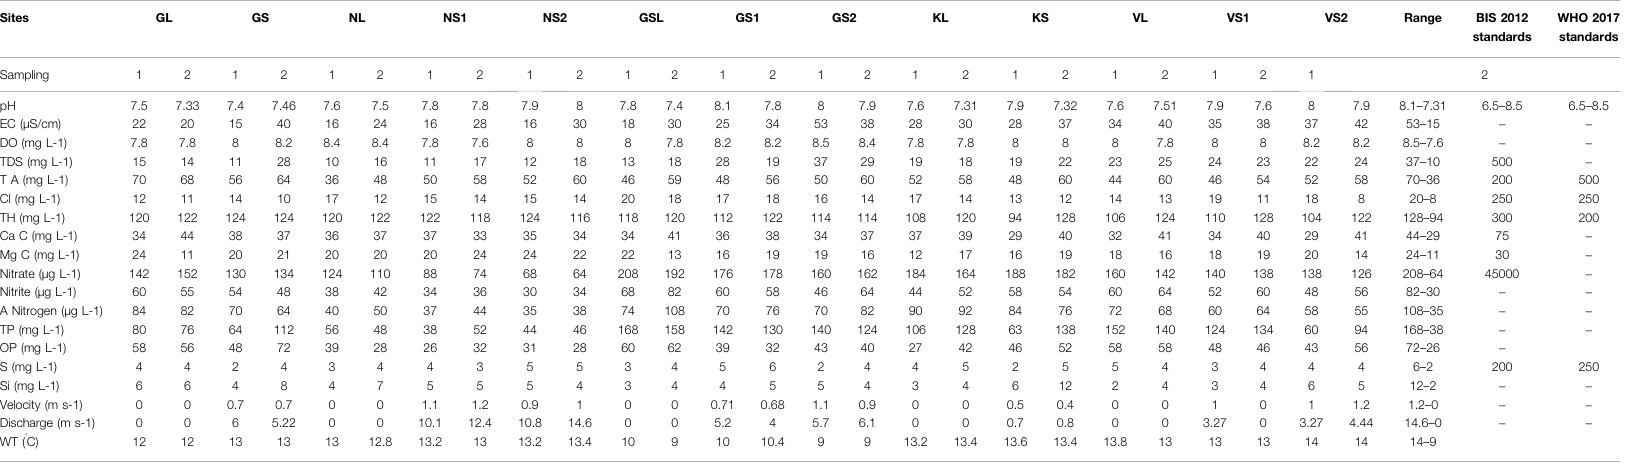
TABLE 2 | Showing the variation in physicochemical parameters in the fi ve HALs and associated streams. Sites